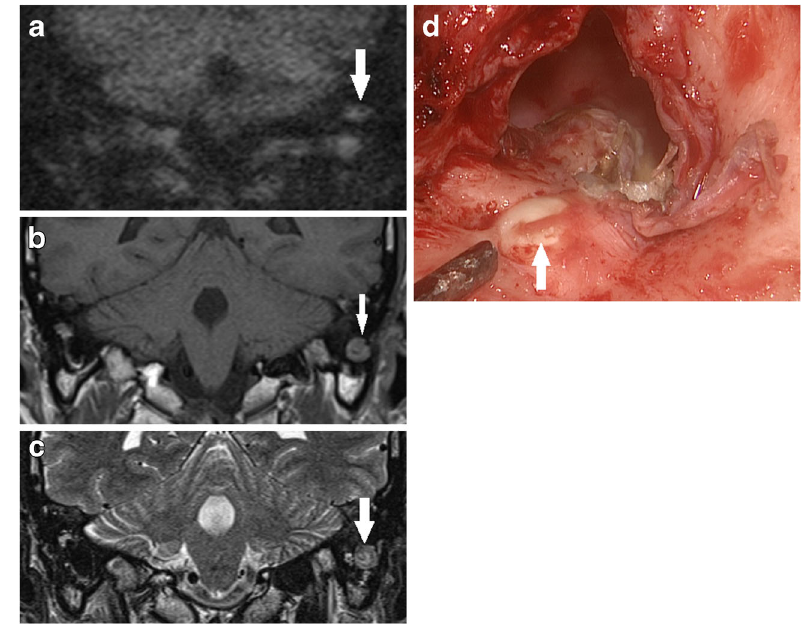
Fig. 13 Using DWI following canal wall down surgery. In a patient who presented with persistent otorrhoea after CWD surgery, a the DWI b1000 images show high signal in the mastoid remnants bilaterally, which corresponded to infected debris/ wax on clinical inspection. b On direct clinical inspection of the left mastoid remnant, which showed the infected debris/wax ( white arrow ), a bony defect ( black arrow ) is noted on the medial wall above the bony labyrinth. The defect communicated with extensive residual cholesteatoma hidden deep in the petrous apex, which was demonstrated by high signal soft tissue ( white arrow ) on the coronal c T2 weighted and d